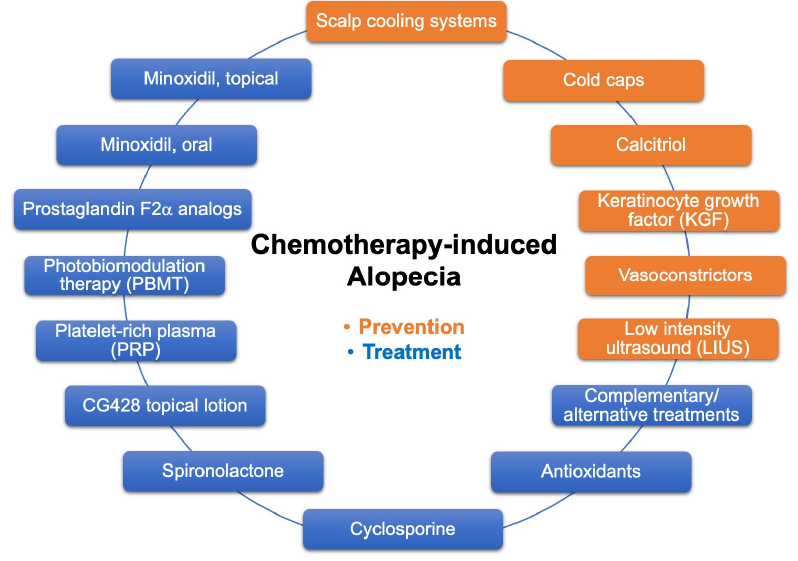
Figure 1. Current approaches to prevent and treat CIA.